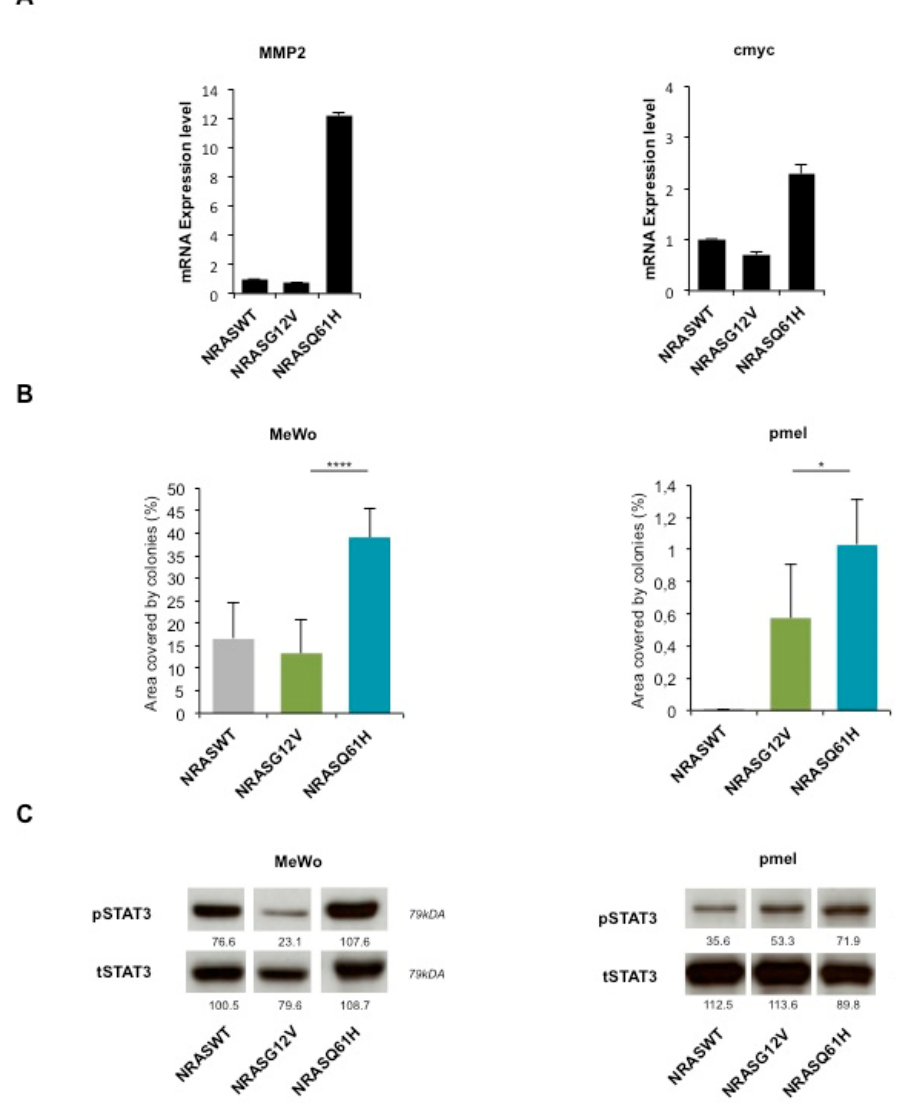
Figure 4. NRASQ61H is more tumorigenic than NRASG12V and activates STAT3. ( A ) mRNA expression levels of STAT3 target genes MMP2 and cMYC in MelSTV. ( B ) Colony formation assay of melanoma cell lines Mewo, and immortalized melanocytes pmel expressing either NRASWT , NRASG12V or NRASQ61H . ( C ) Western blot shows respective expression of P-STAT3 and total STAT3. * p < 0.05, **** p < 0.0001.